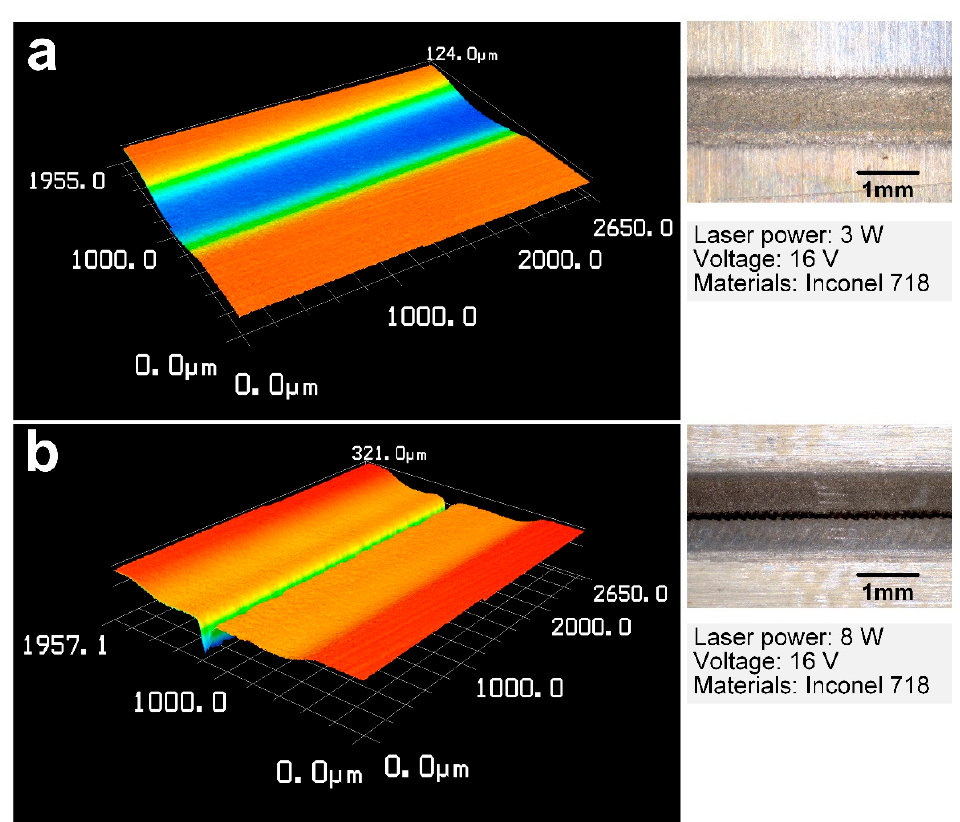
Figure 4. Three-dimensional morphology of the microgrooves machined by Laser-STEM at a laser power of ( a ) 3 W, and ( b ) 8 W. power of ( a ) 3 W, and ( b ) 8